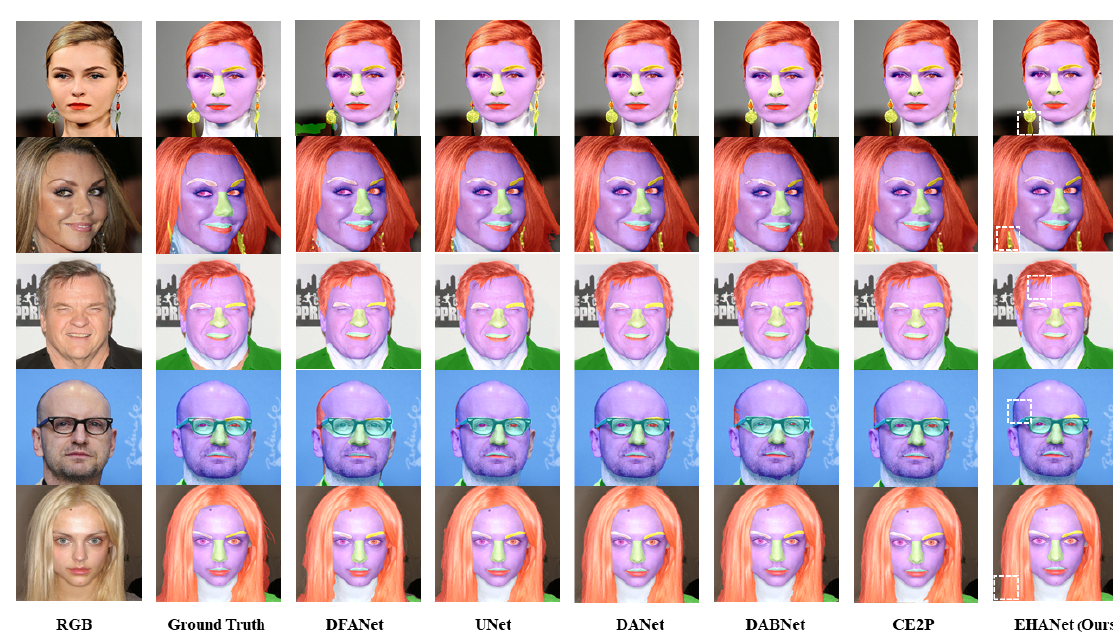
Figure 6. Qualitative comparisons on CelebAMask-HQ. Zoom in for more details in electronic version.